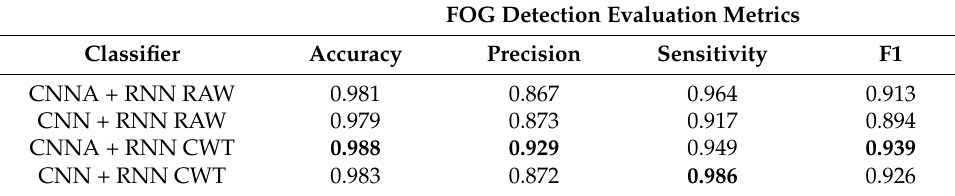
Table 10. Evaluation metrics for four classifiers.